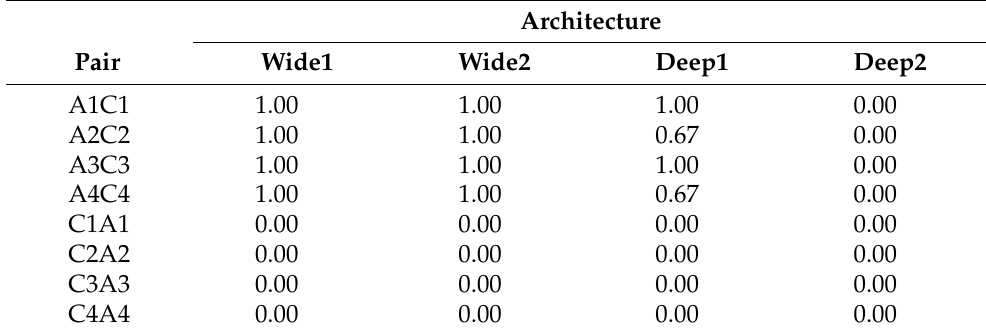
Table 5. Agents’ F1-score by pair in the LS transitivity test.